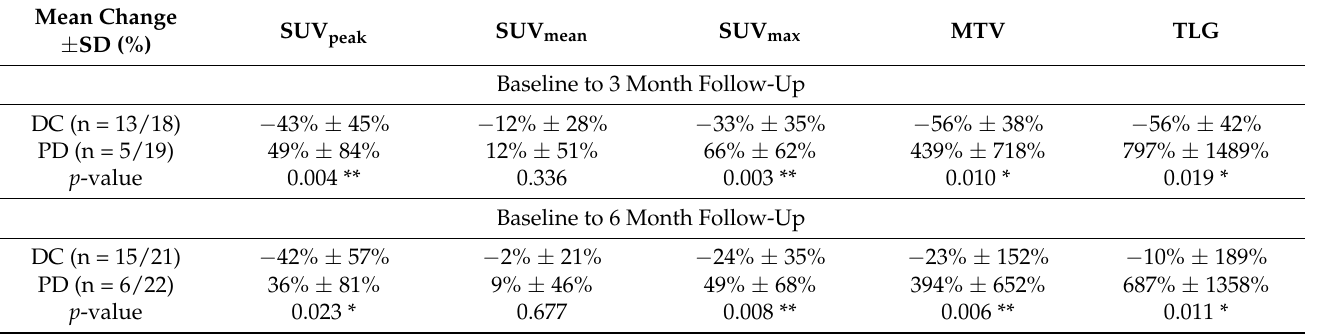
Table 1. Mean changes and SD (%) of PET-parameters in patients with DC and PD according to RECIST from baseline to 3 and 6 month follow-up